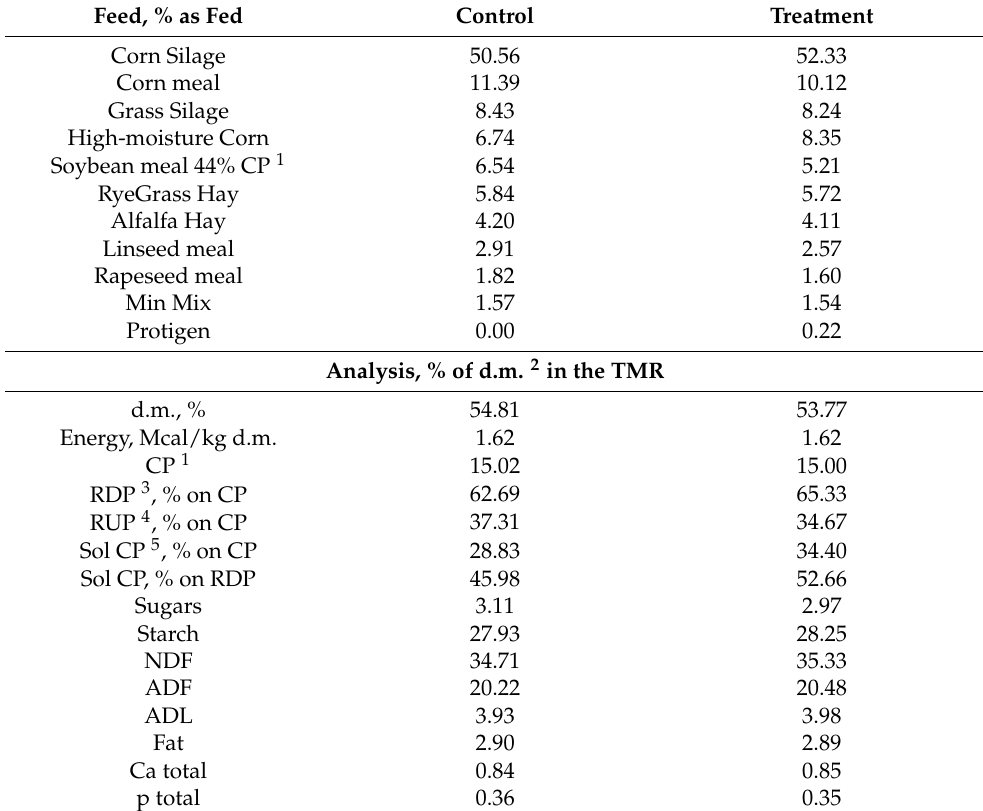
Table 1. Composition and nutritional values of the two diets tested, as predicted by the rationing software (Plurimix, Fabermatica, Ostiano (CR), Italy). Feed, % as Fed Control Treatment Corn